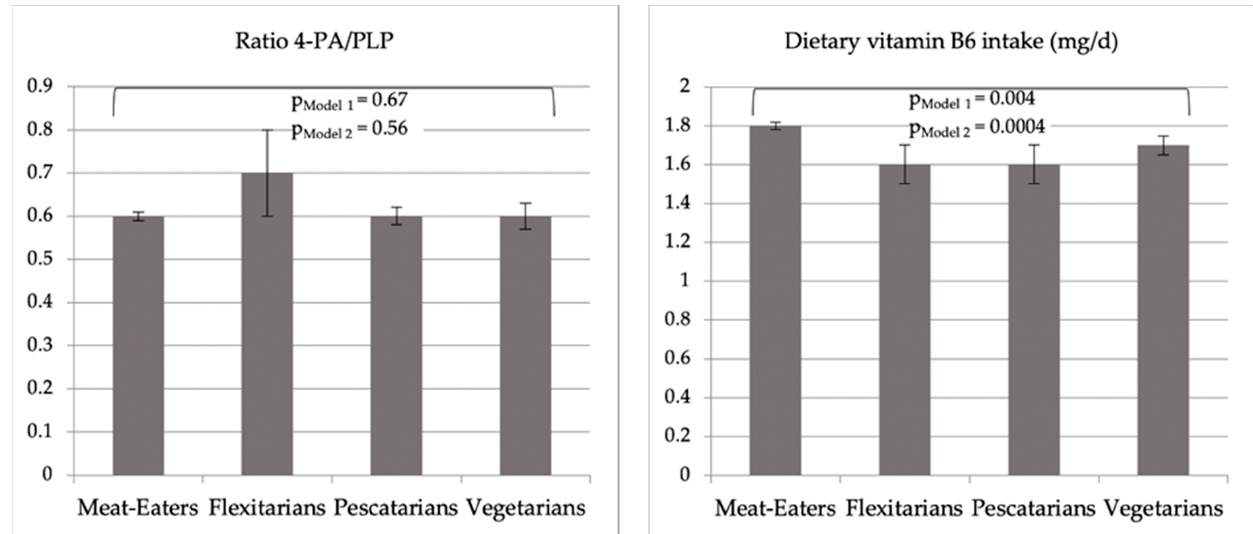
Figure 1. Geometric mean values of PLP (pyridoxal-5 (cid:48) -phosphate) and 4-PA (4-pyridoxic acid) serum concentrations (nmol/L), their ratio, and total vitamin B6 intake (mg/d) of study participants following a meat-eating, flexitarian,